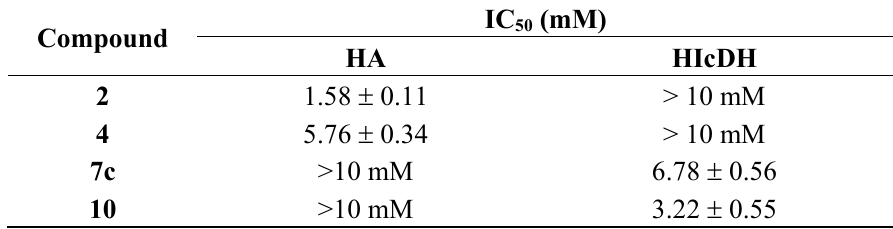
Table 2. Enzyme inhibitory potential of compounds 2 , 4 , 7c and 10 . Values are the means of three independent determinations ±